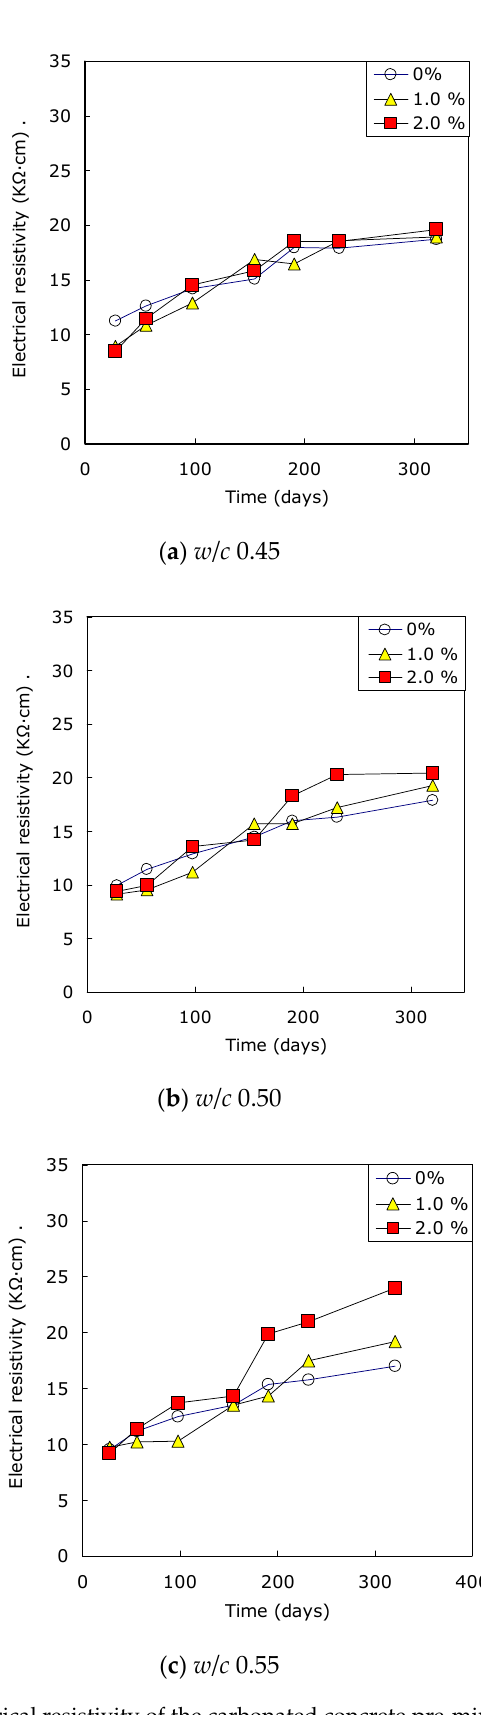
Figure 14. Electrical resistivity of the carbonated concrete pre-mixed with chloride.